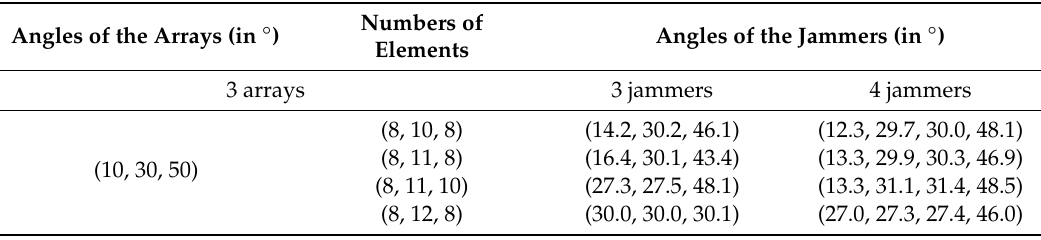
Table 4. Optimized angles of the jammers for di ff erent numbers of jammers with respect to the three-array networks with di ff erent numbers of elements in a single-target scene. Angles of the Arrays (in ◦